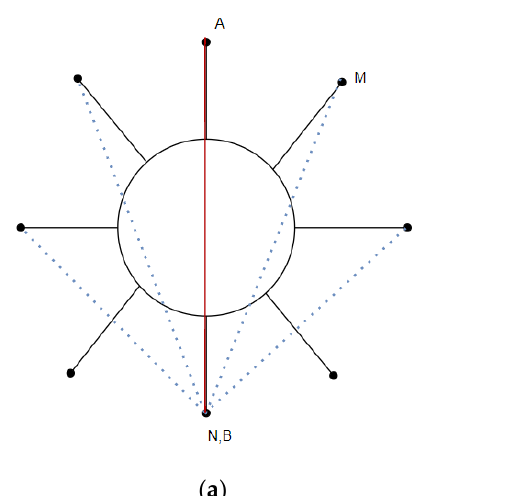
Figure 3. Acquisition method and measurement calculation ( a ), forcing electrodes A and B and measuring electrodes M and N ( b ).